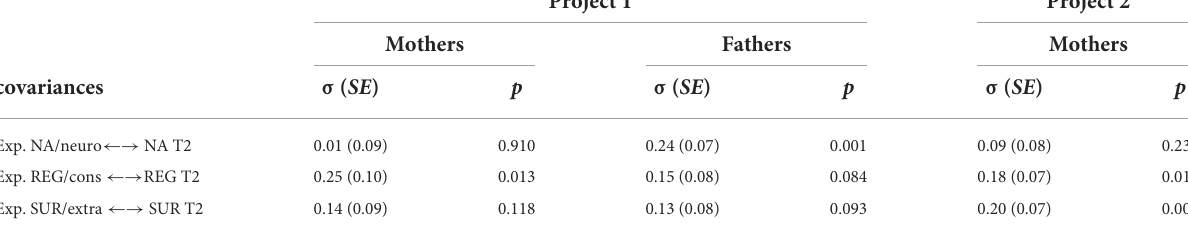
TABLE 4 Associations between expected temperament T1 and infant temperament